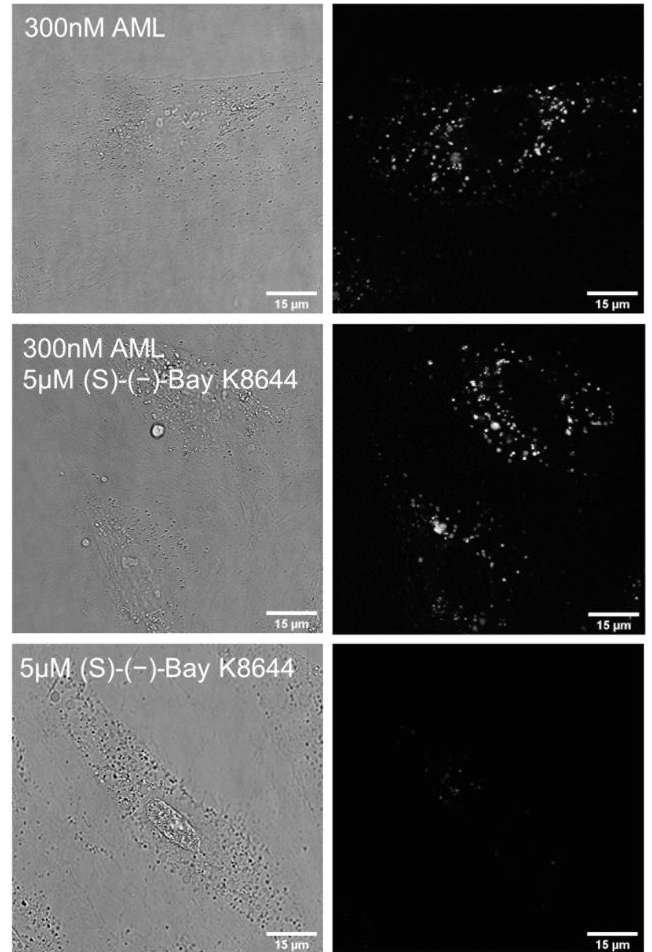
Figure 3. Phase contrast and DAPI channel fluorescence of living A7r5 cells. 300 nM AML (upper row), 5 µ M ( S )-( − )-Bay K8644 (middle) and competitive 300 nM AML + 5 µ M ( S )-( − )-Bay K8644. The cells were incubated for 1 h in HBSS/HEPES (pH 7.4) containing indicated concentrations of ligands, washed with HBSS and imaged in HBSS on confocal Leica SP8 microscope using settings as described in the Materials and Methods section.